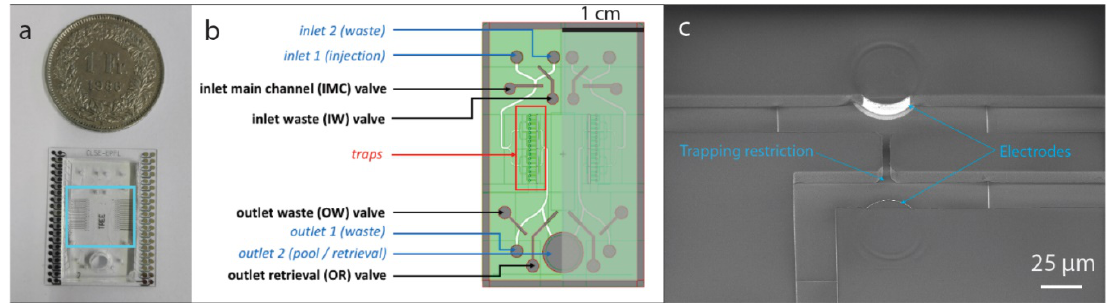
Figure 1. Device layout description and fabrication. ( a ) Picture of the microfluidic chip used for the experiments. The chip hosts two symmetrical parallel channels that share the outlet-well used for cell recovery. The blue box indicates the area where the cells are trapped in hydrodynamic sites. ( b ) Microfluidic layout of the chip. The SU-8 based microfluidic main channels are shown in green, while PDMS control channels are depicted in gray. When a cell enters the chip through inlet 1, it can be directed either towards the traps for immobilization and observation or to the inlet 2 if it needs to be discarded. After release for a trap, a cell can be recovered from the pool at outlet 2 or disposed through the outlet waste. ( c ) Magnified scanning electron microscopy image of a trap with electrodes embedded in the microfluidic channel. The aperture is 5 µm in width and the electrode extrusion from the microfluidic channel measures approximately 7 µm.